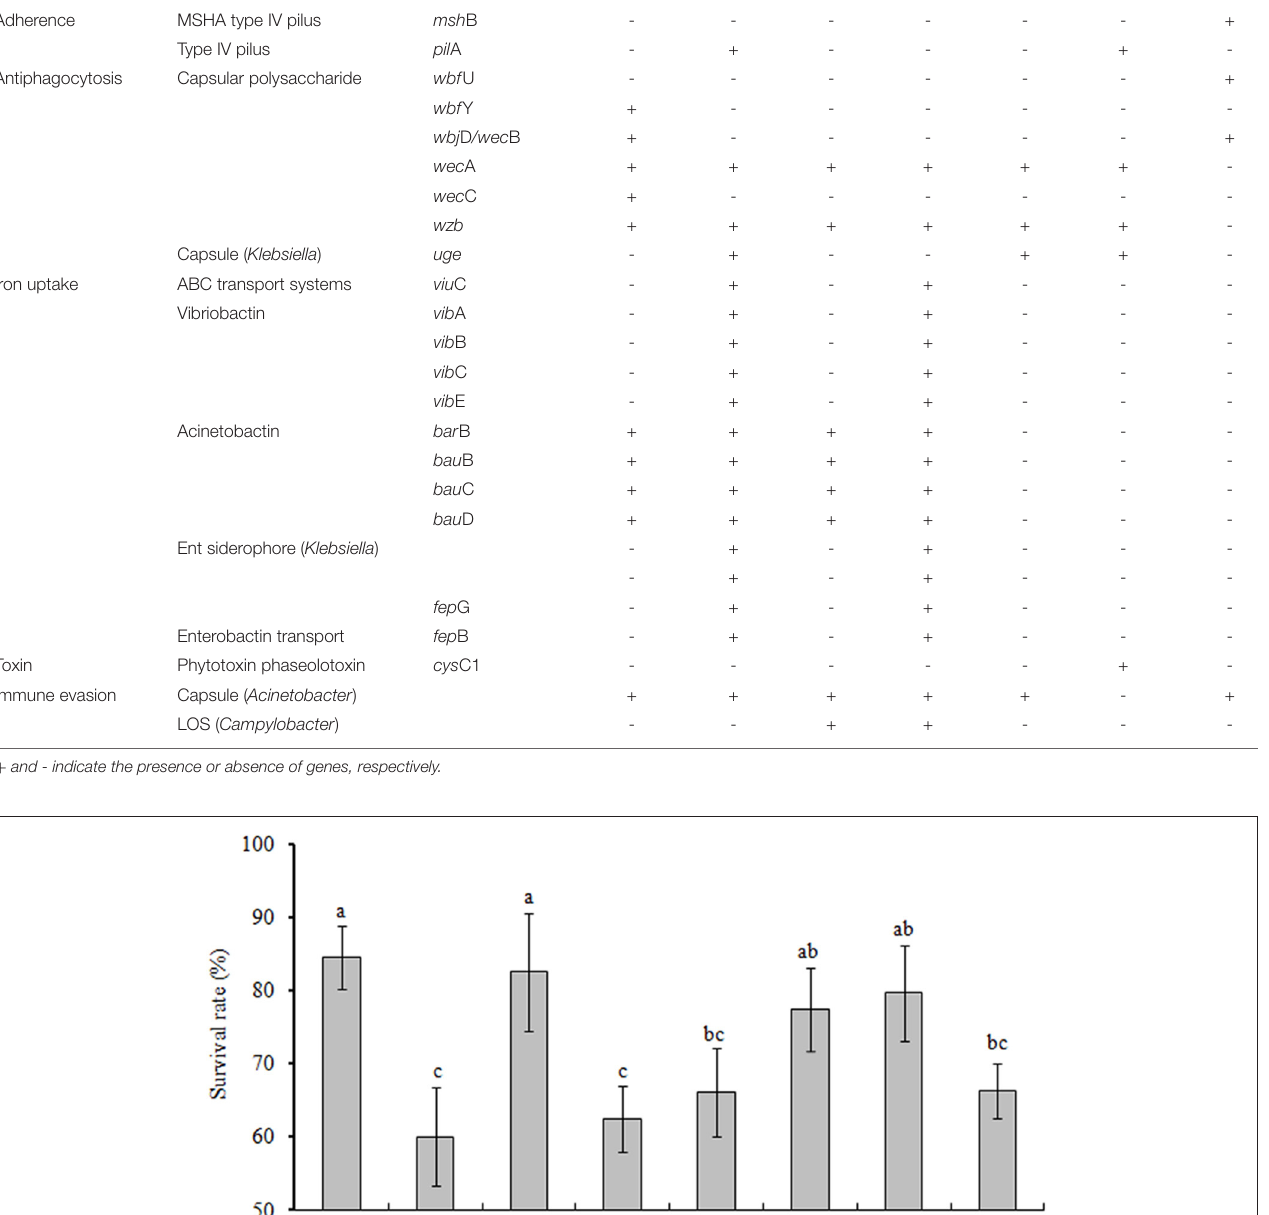
TABLE 2 | The differed virulence factors among the seven V. alginolyticus strains. VF class